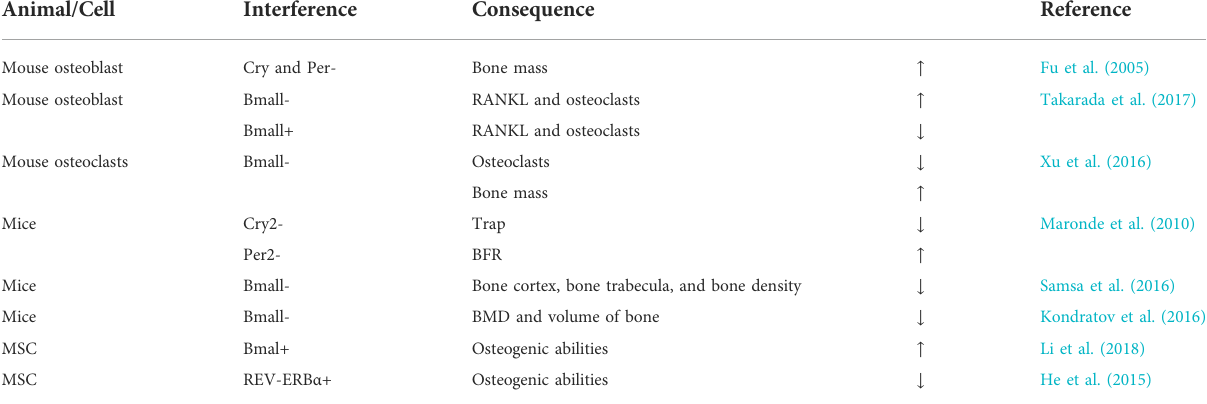
TABLE 4 Biological rhythm disorders in bone tissue lead to osteoporosis in cell/gene knockout models.